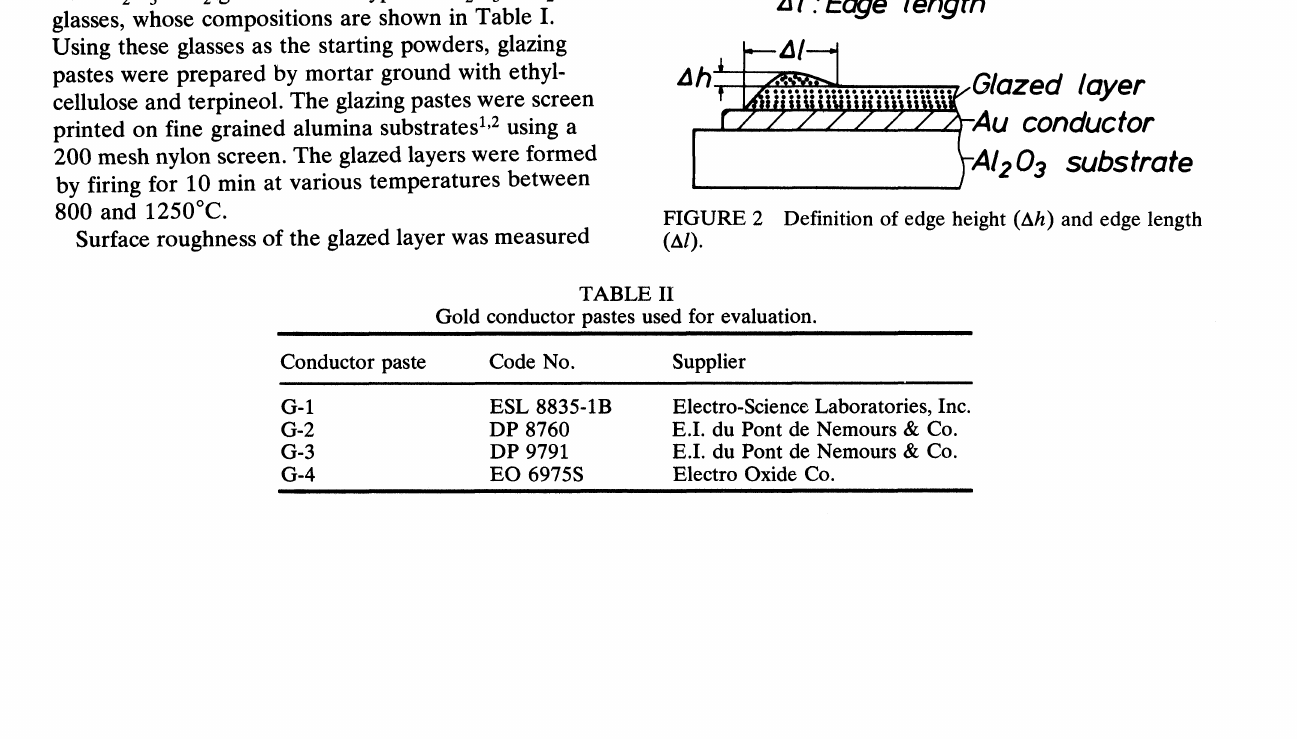
FIGURE 2 Definition of edge height (Ah) and edge length